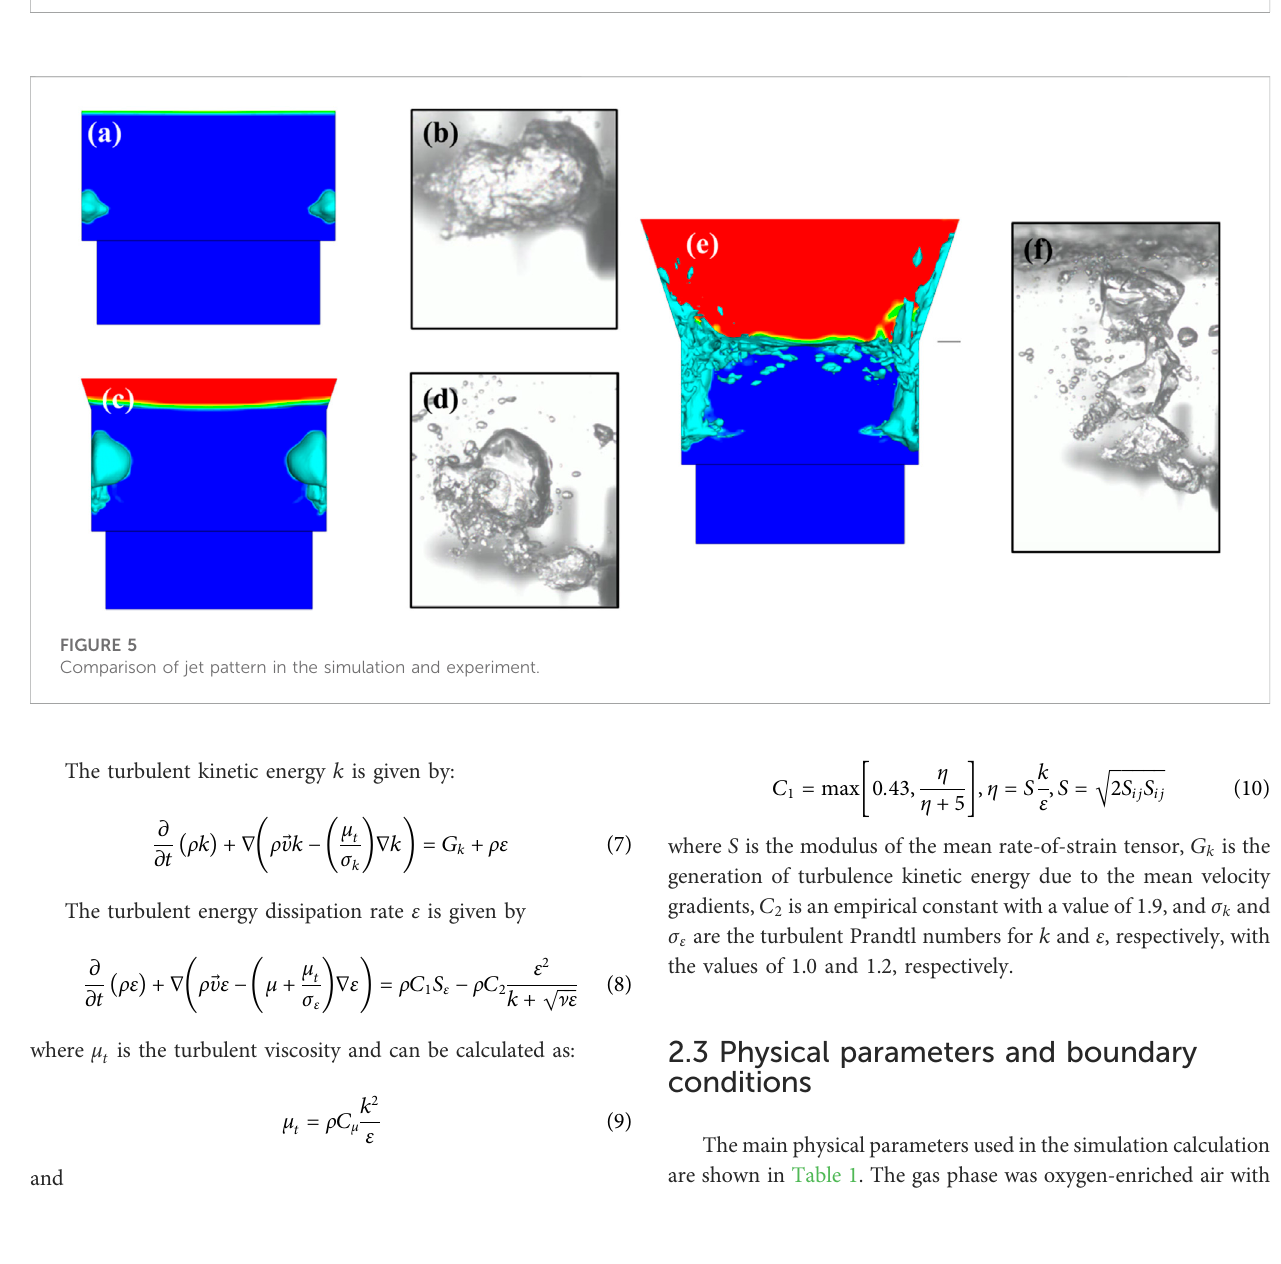
FIGURE 4 Side-blown furnace water model test platform.